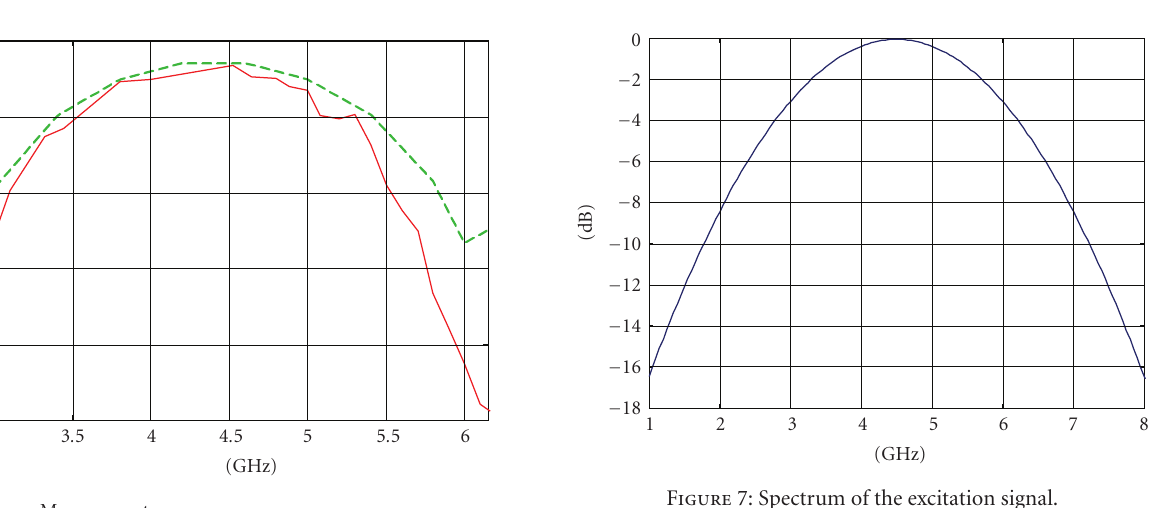
Figure 7: Spectrum of the excitation signal.